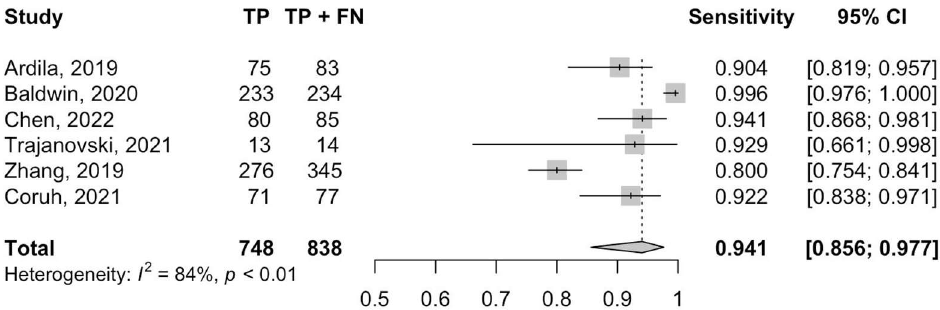
Figure 2. Forest plot of the pooled sensitivity of DL in the detection and classification of lung cancer [37–42].